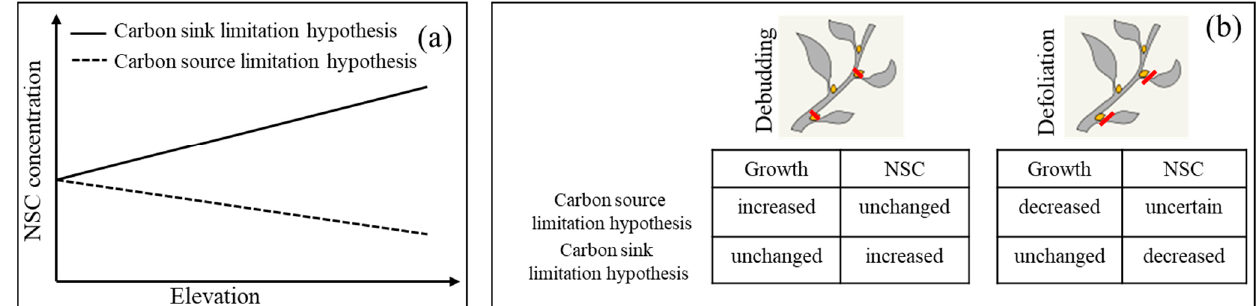
Figure 1. The conceptual framework of this research. ( a ) Possible trends of non-structural carbohy- drates (NSC) concentrations along temperature gradients predicted by carbon sink and carbon